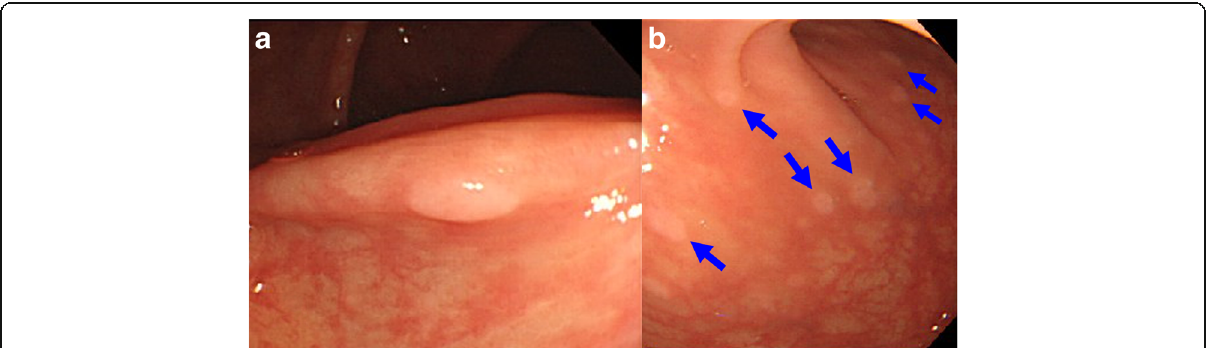
Fig. 2 Metastatic mucosal polyp in transverse colon. a A small elevated sessile polyp (4 mm in diameter) was found in the transverse colon. Polypectomy was endoscopically performed and pathological examination revealed it to be a signet-ring cell carcinoma. b Multiple metastatic polyps in the transverse colon: re-examination by colonoscopy, performed 4 months after the diagnosis of metastasis, showed an increase in the numbers of metastatic polyps throughout the large intestine. Five biopsies were taken from the ascending colon, transverse colon, and rectum and all were confirmed to be signet-ring cell carcinoma